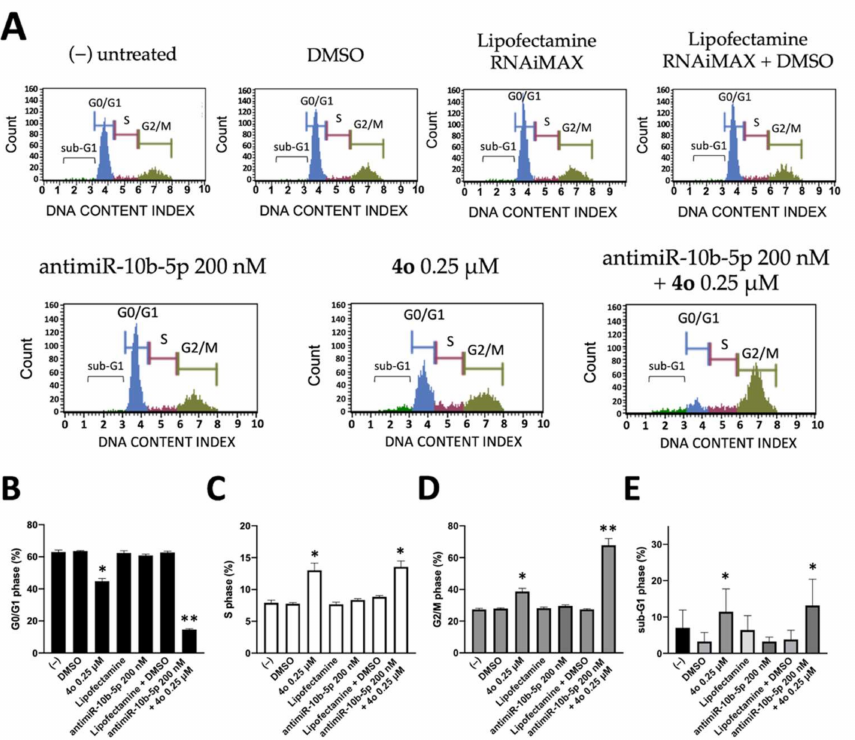
Figure 5. Effects of compound 4o and antimiR-10b-5p on cell cycle distribution. Representative plot obtained from cell cycle analysis after 72 h treatment with compound 4o or antimir-10b-5p alone and in combination ( A ) and summary of cells percentage distribution following treatment ( B – E ). Results represent mean ± SD ( n = 3). p < 0.05 (*, significant), p < 0.01 (**; highly